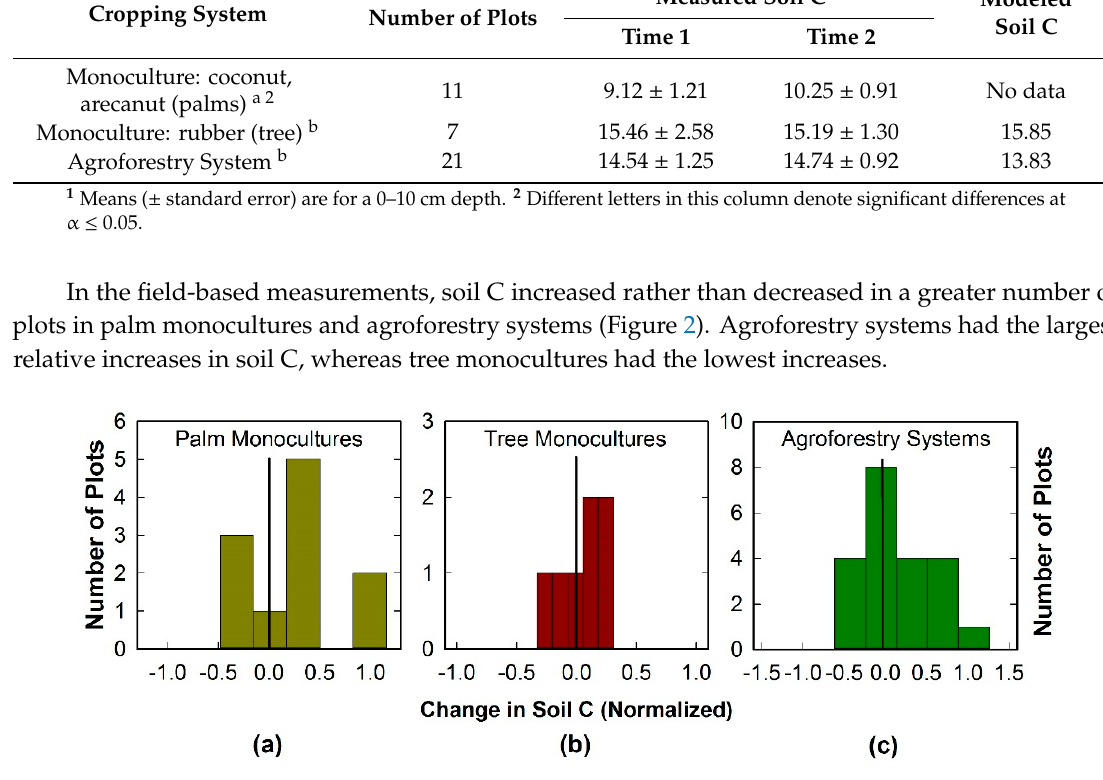
Table 1. Soil carbon (Mg ha − 1 ) in Kerala agroforestry systems over an 8-year period. Cropping System Number of Plots Measured Soil C 1 Modeled Soil C Time 1 Time 2 Time 2